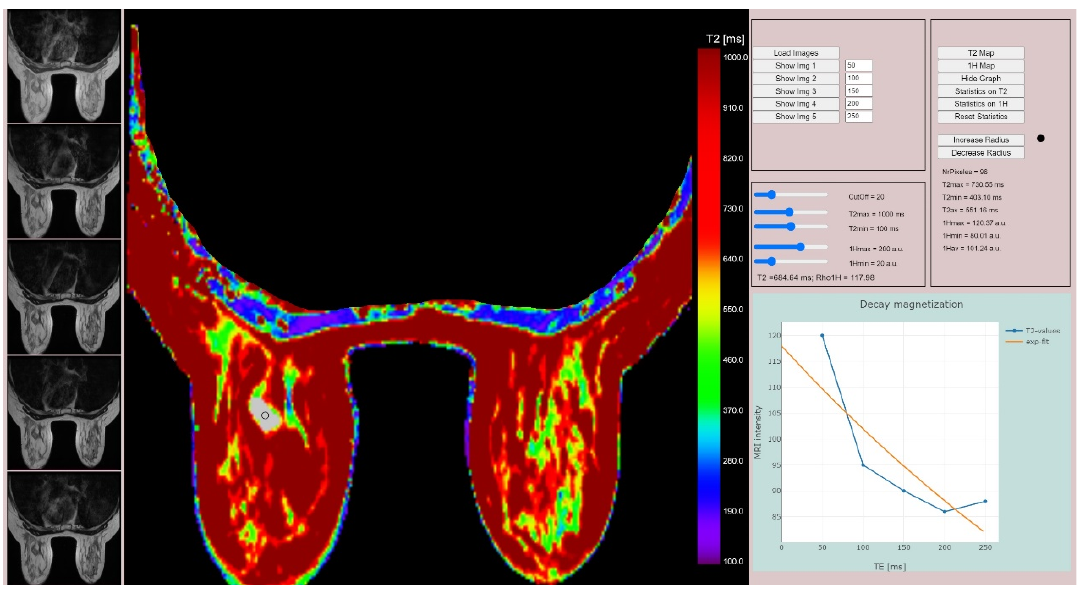
Figure 4. MR relaxometry map–Extracting relaxometry data. The left sided breast tumor is man ually delineated on relaxometry map (grey area), providing the decay magnetization curve (lower right side of the image).